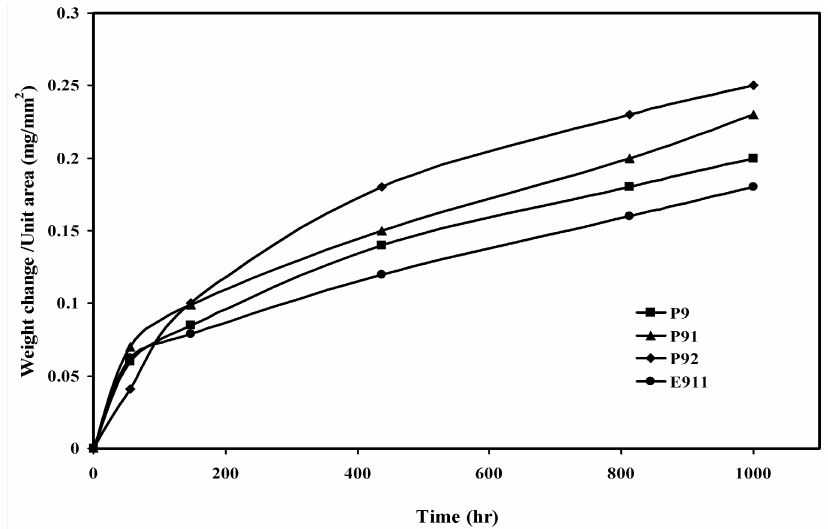
Figure 2. Weight change vs. time plots for the oxidation of alloys at 973 K in air for 1000 h.